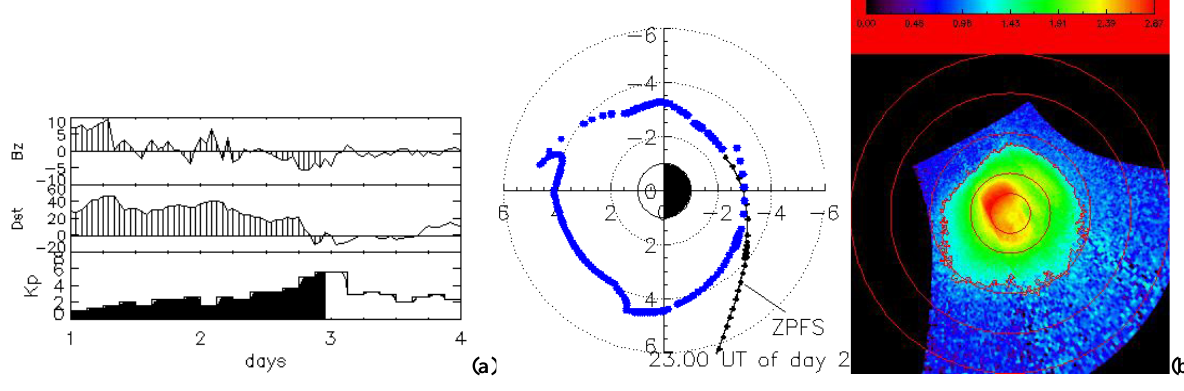
Fig. 3: Same as Fig. 1 for 9 June 2001, 23h00 (left panel (a), simulation) and 23h04 UT